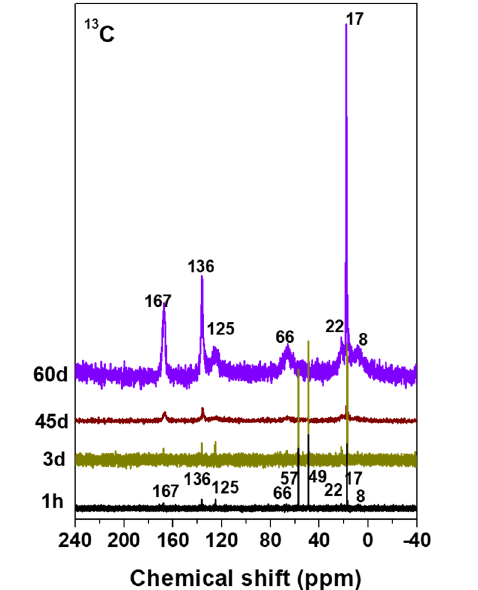
Figure 2. 13 C NMR spectra for the polysiloxane hybrids synthesized from [TMOS]/[MPTS] mixture at room temperature for different times.